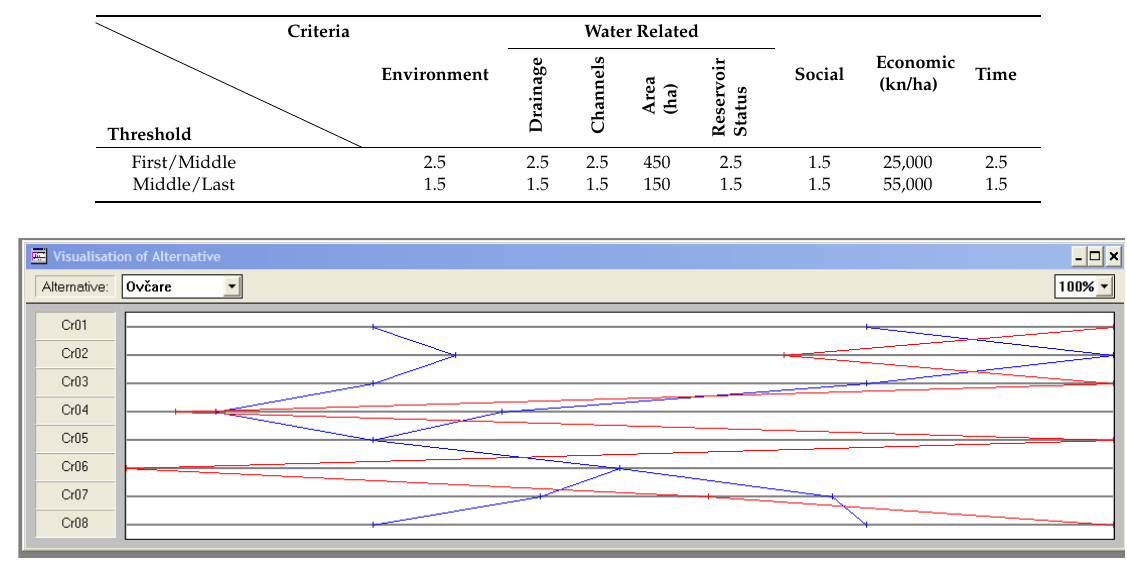
Figure 6. Visualization of alternative Ovčare (red) with categories thresholds (blue) for Scenario 1.